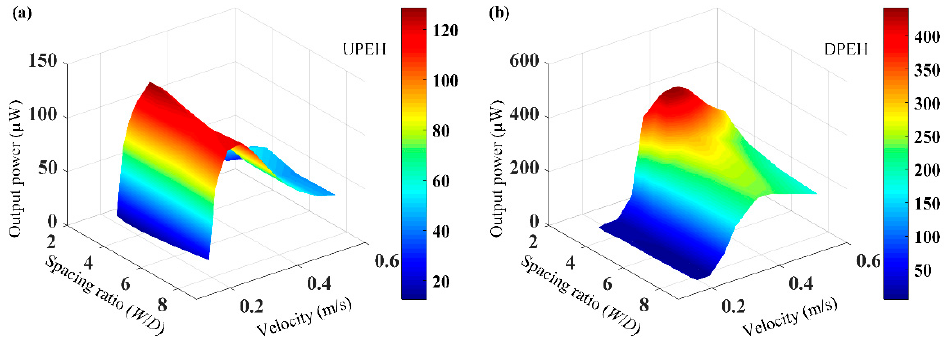
Figure 9. Energy harvesting performance of the two tandem PEHs versus spacing ratio W / D and water velocity: ( a ) UPEH, ( b ) DPEH.